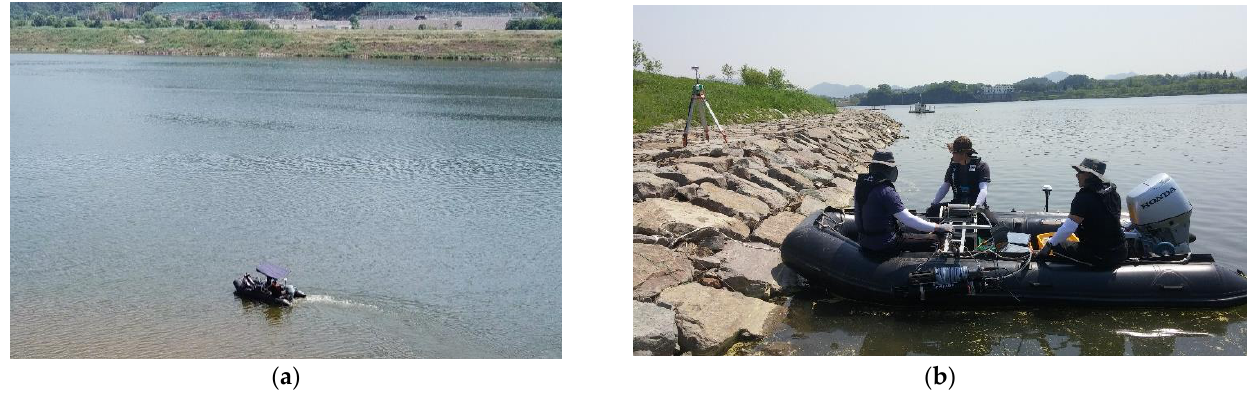
Figure 4. ( a ) Field measurements and ( b ) measurement equipment (LISST-100X was attached to the boat). the